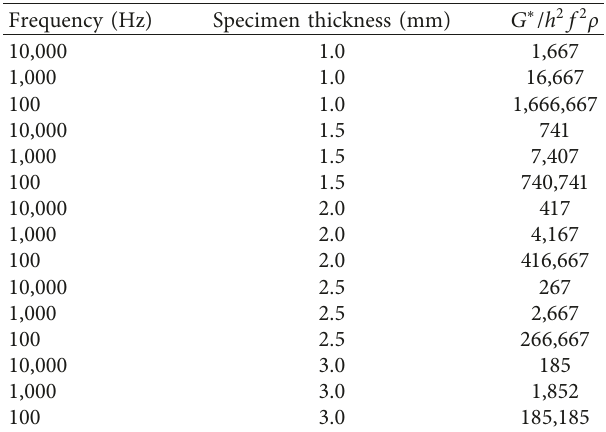
Figure 5: The force needed to oscillate two specimens. Table 2: The G / h 2 f 2 ρ ratio for different rubber specimen sizes and ∗